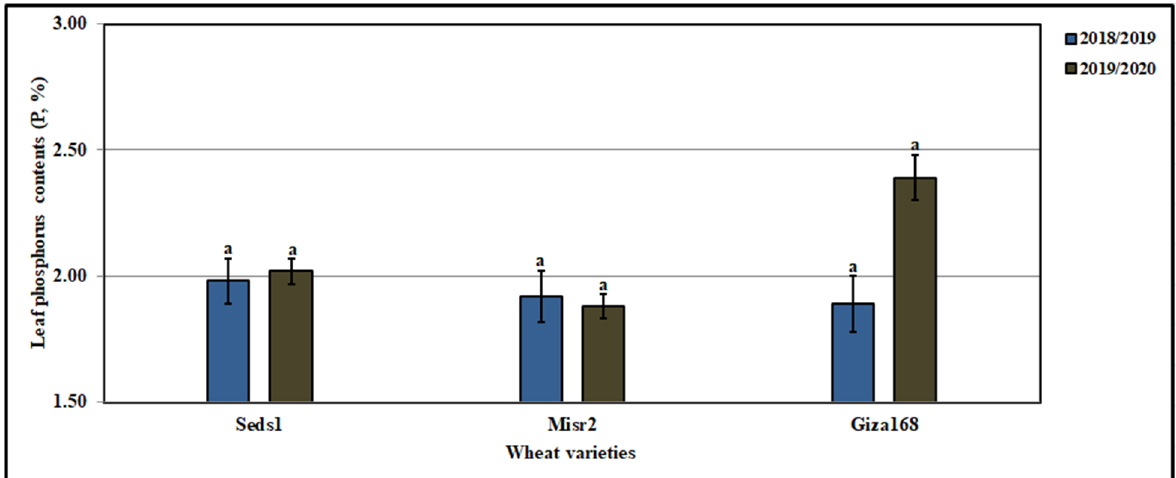
Figure 23. Influence of wheat varieties on leaf phosphorus contents (P, %) in clay loam soil in 2018/2019 and 2019/2020 seasons. Bars in the same years with a different letter indicate significant differences between treatments at p ≤ 0.01. HS 1, HS 2 , HS 3 represent HS applied as foliar spray at 1.0, 2.0, 4.0 g L − 1 , respectively, HS 4 , HS 5 , HS 6 represent HS applied as soil application at 5.04, 7.56, 10.08 kg ha − 1 .